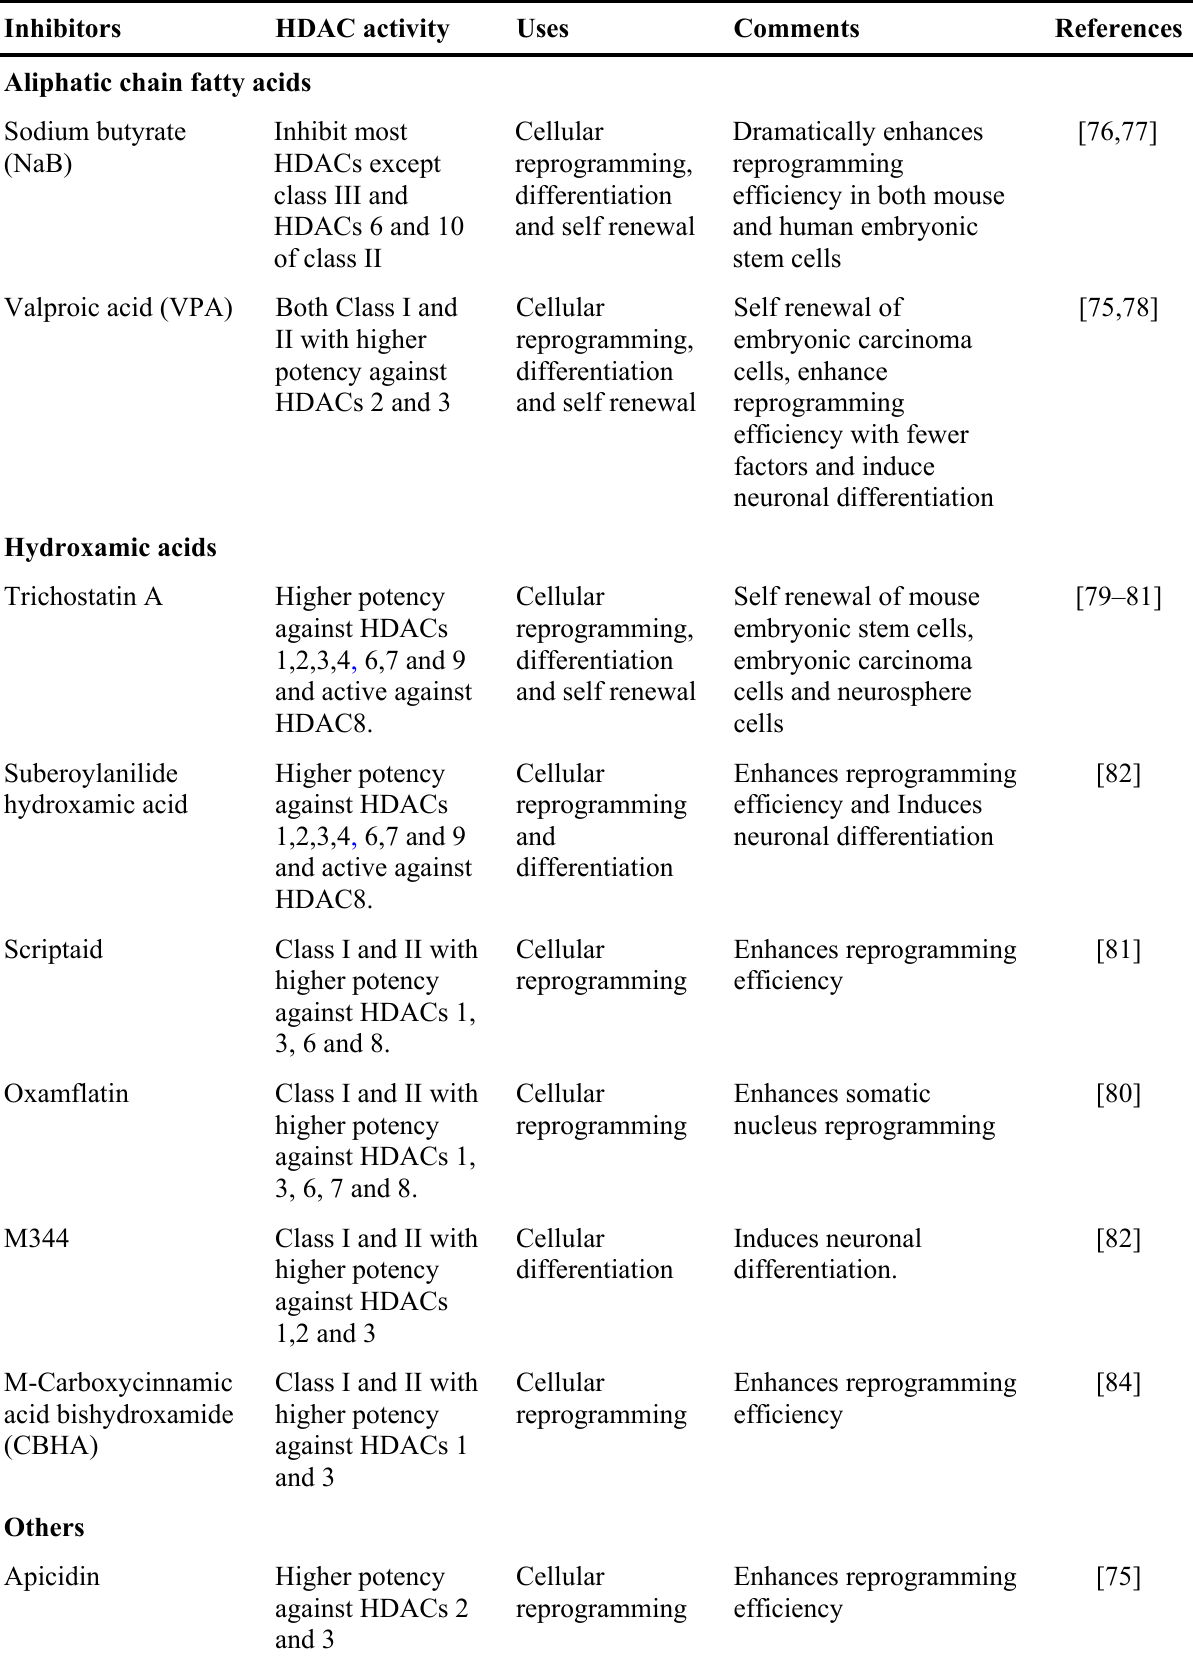
Table 2. HDAC inhibitors and their activity and uses in regenerative medicine.